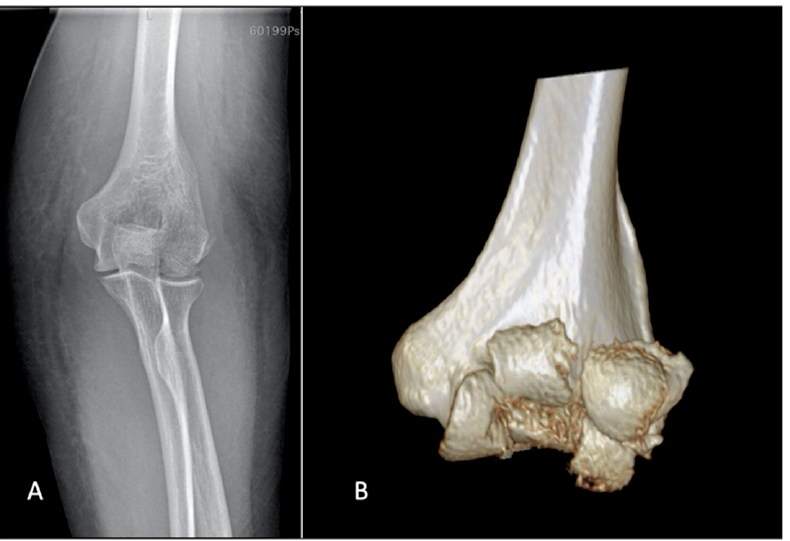
Figure 3. ( A ) The anteroposterior view barely shows involvement of the joint surface. ( B ) The CT scan portrays fracture of both the capitellum and the trochlea.